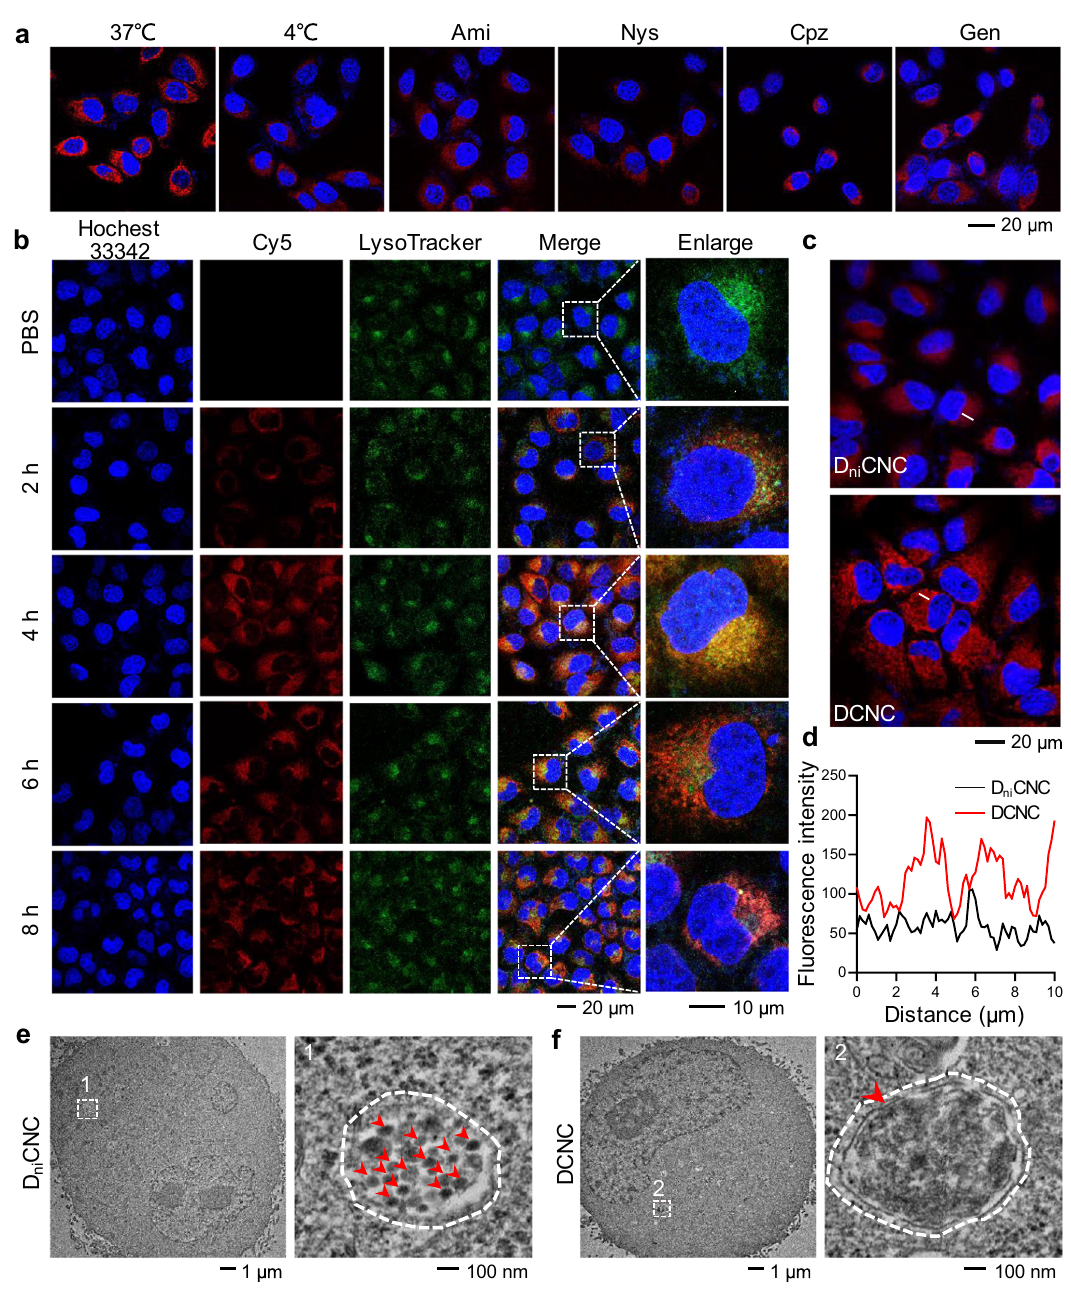
Fig.4|Lysosomalacidiccondition-inducedassemblyofDCNC.a Representative confocal microscopy images of MCF-7 cells treated with different endocytosis inhibitorsandthenincubatedwith1 μ MDCNCfor6h.Amiamiloride,Nysnystatin, Cpzchlorpromazine, Gengenistein. b Representative confocal microscopyimages of MCF-7 cells after incubation with DCNC for varied time durations. Cell nuclei were stained with Hoechst 33342 (blue); late endosome/lysosomes were stained